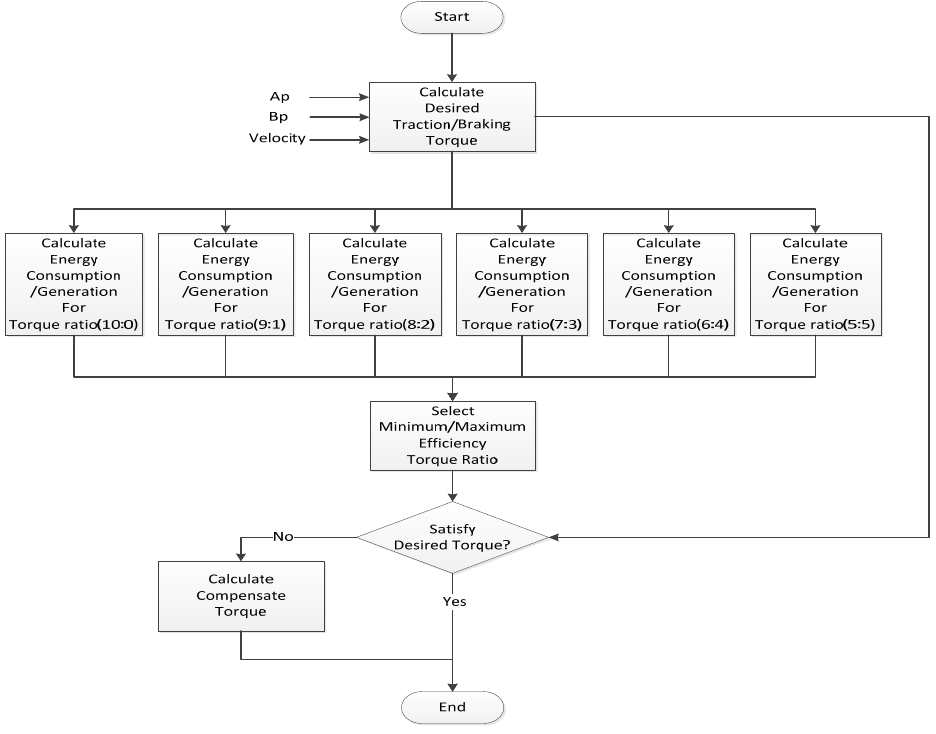
Figure 7. Flow chart of the strategy for optimizing driving